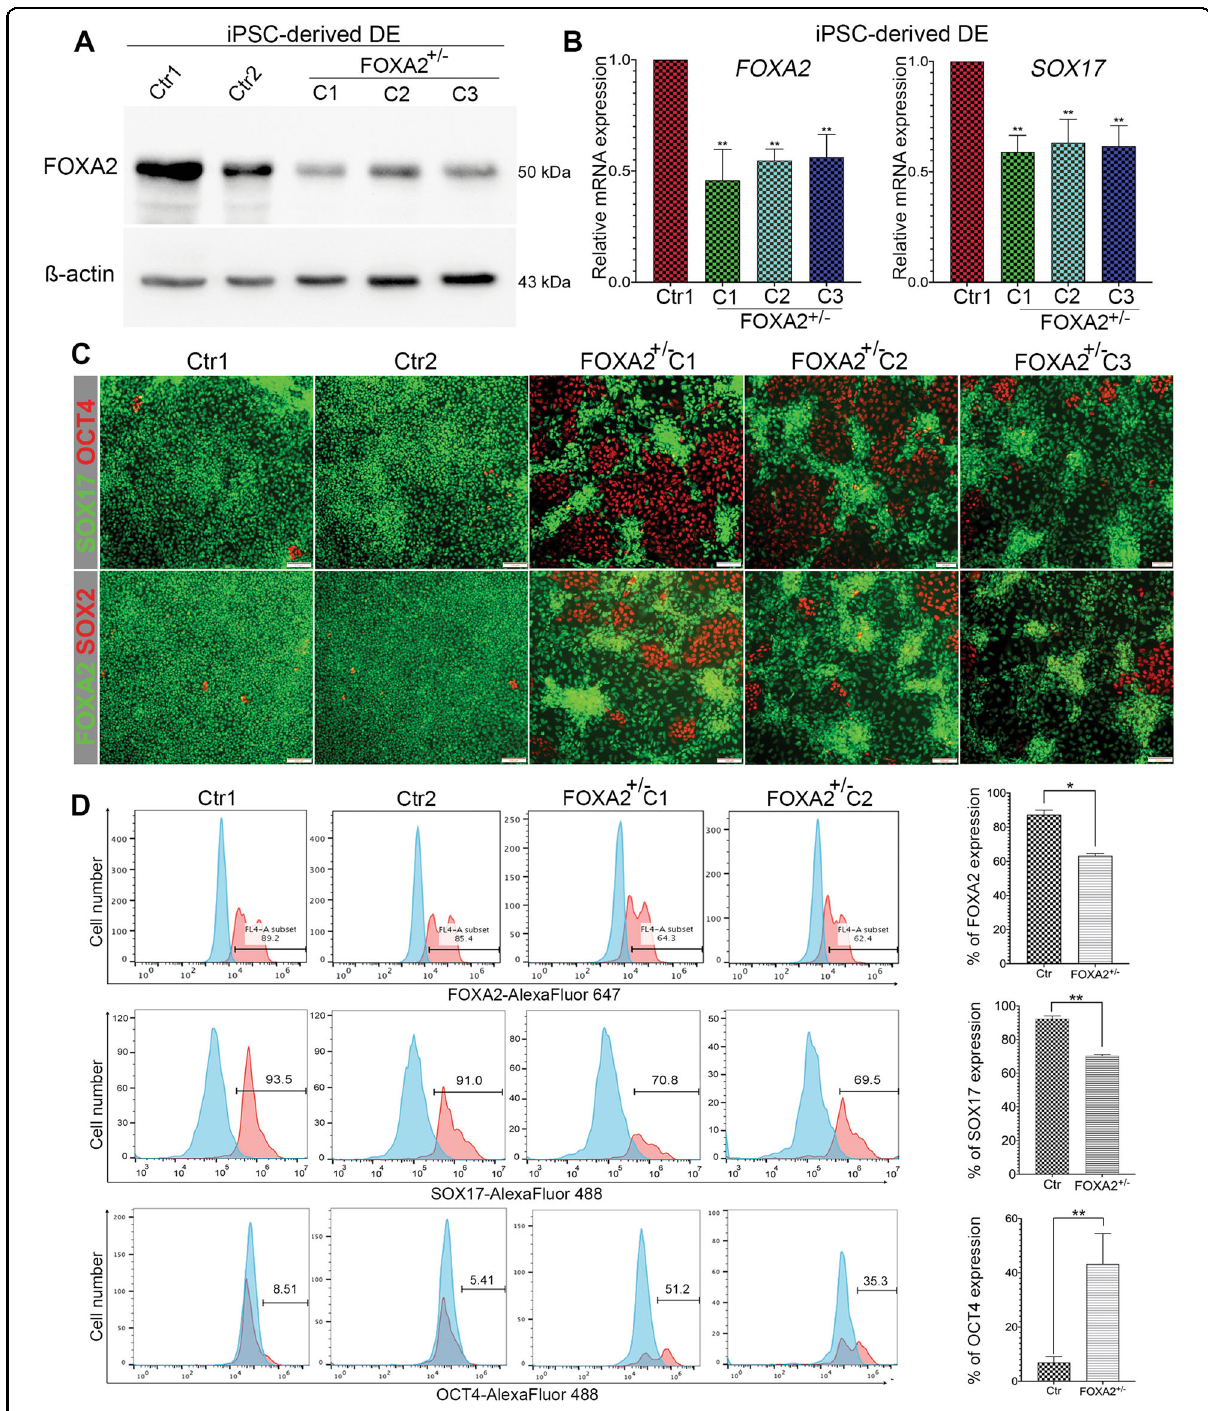
Fig. 1 Effect of FOXA2 haploinsuf fi ciency on de fi nitive endoderm (DE) formation. A Western blotting of FOXA2 expression in the de fi nitive endoderm (DE) derived from Ctr-iPSCs and FOXA2 + / − iPSCs. B qPCR quanti fi cation of the expression of DE markers, FOXA2 and SOX17 in DE derived from Ctr-iPSCs and FOXA2 + / − iPSCs ( n = 3 ). C Representative immuno fl uorescent images showing the expression of SOX17 and OCT4 or FOXA2 and SOX2 in DE derived from Ctr-iPSCs and FOXA2 + / − iPSCs. D Representative fl ow cytometry histograms and its quanti fi cation showing the expression of FOXA2, SOX17, and OCT4 in DE derived from Ctr-iPSCs and FOXA2 + / − iPSCs. Data are represented as mean ± SD; * p < 0.05, ** p < 0.01, *** p <